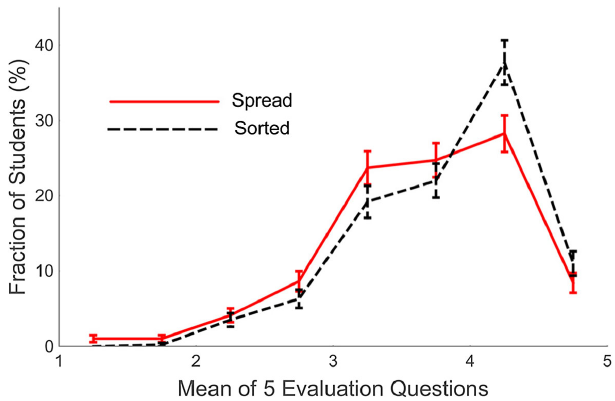
FIG. 5. Mean of the five evaluation questions about the practicals for the two types of groups. 1 is the least favorable, 5 the